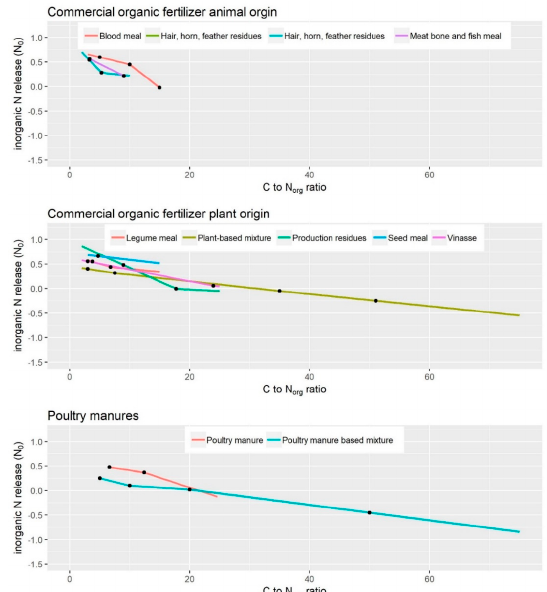
Figure 6. Dependency of potential inorganic N release within 150 days after organic fertilizer application on the fertilizer C to organic N ratio in different fertilizer classes. Agronomy 2020 , 10 , x FOR PEER REVIEW